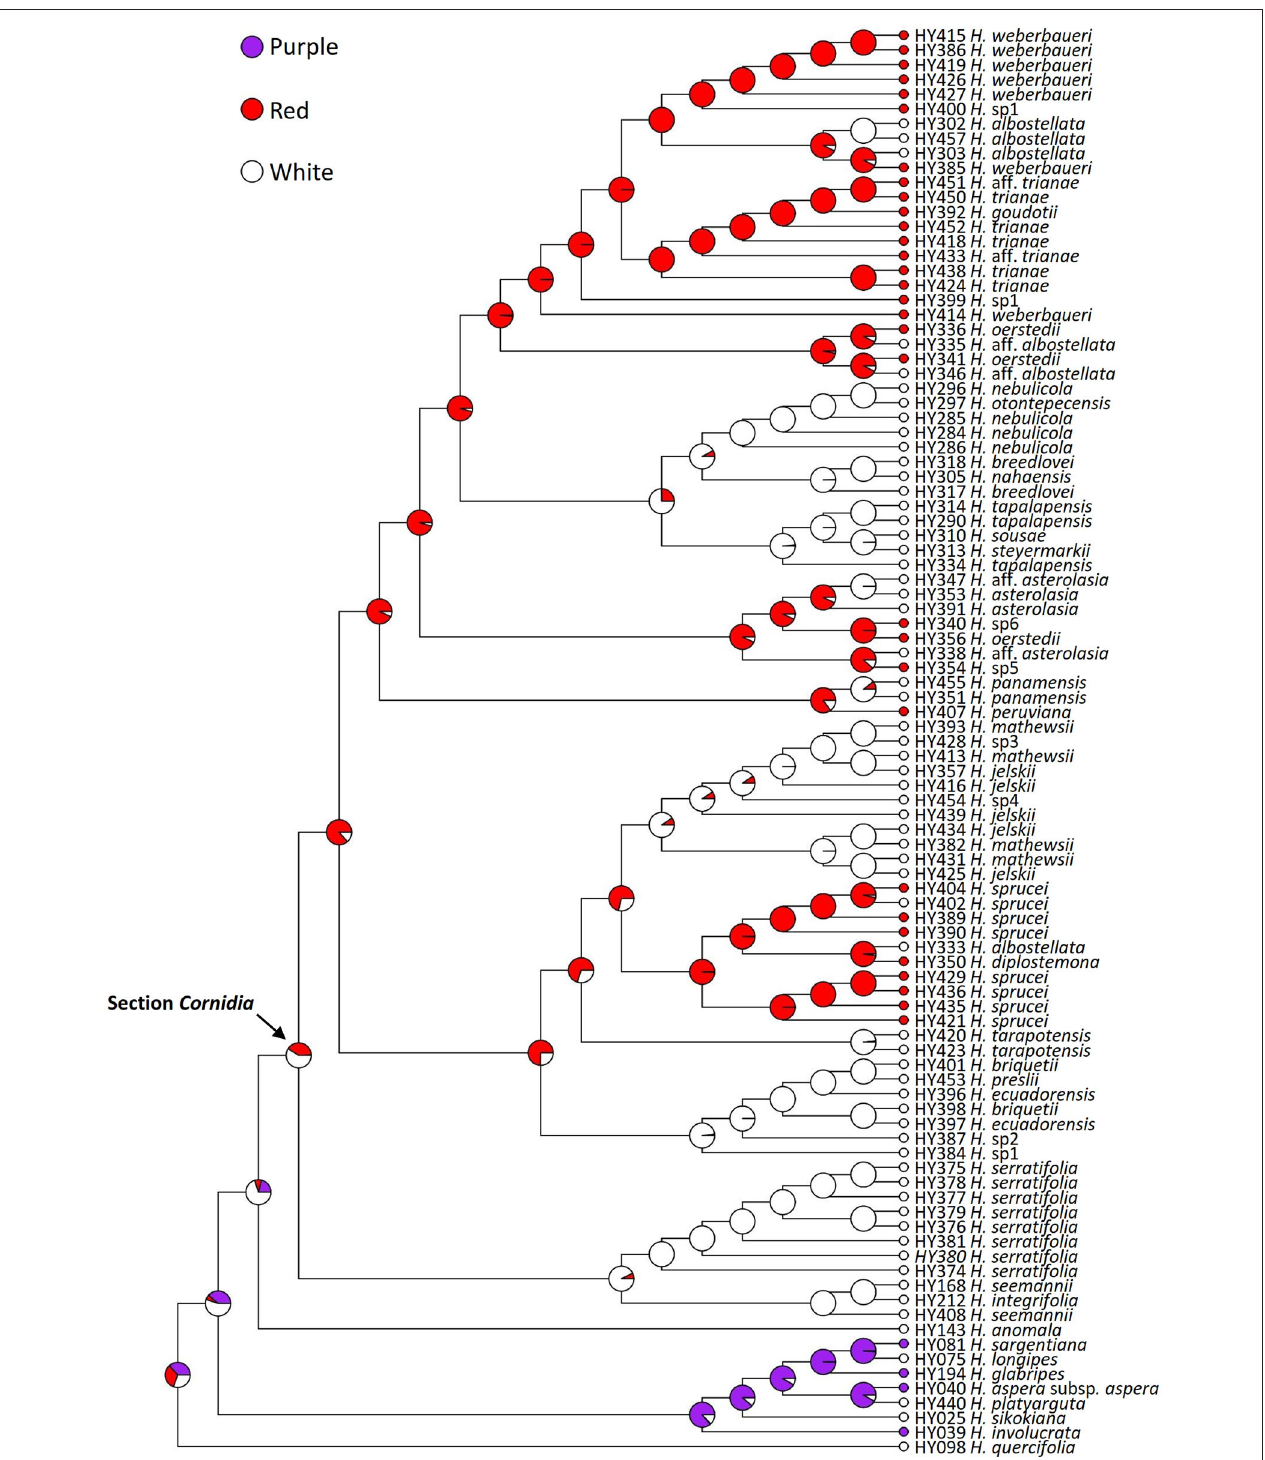
FIGURE 5 | Ancestral reconstruction of flower color in Hydrangea section Cornidia using Bayesian stochastic character mapping. Pies indicate the proportion for each color from 1,000 simulations on the phylogeny resulting from the combined analysis.